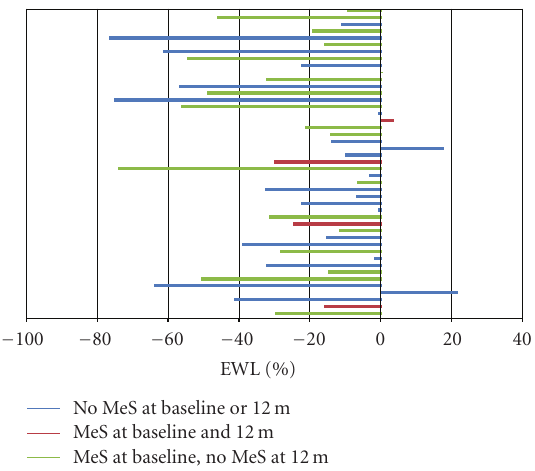
Figure 1: %EWL 12 m